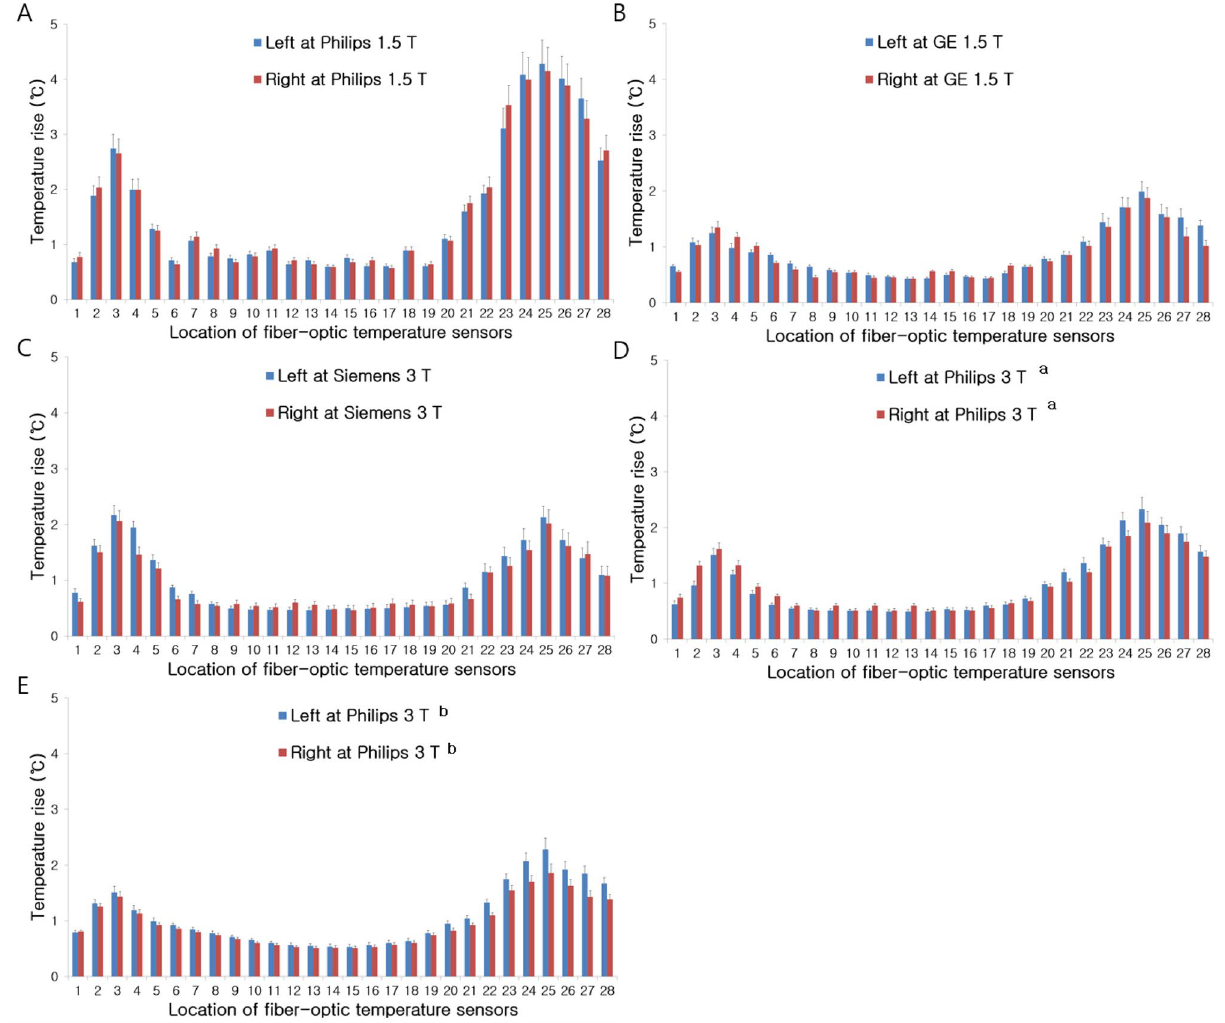
Figure 3. Temperature rise measured via fiber-optic Bragg grating temperature sensors on both sides of the artificial hip joints at 1.5 T Philips with T1w TSE sequence ( A ), 1.5 T GE with IR TSE sequence ( B ), 3 T Siemens with T1 TIRM sequence ( C ), and 3 T Philips with T1w TSE sequence ( D and E ) and imaging parameters as described in Supplementary Table 1. Temperature rise by other two sequences for each scanner is not shown here. The column height is the temperature rise and the error bar is the standard deviation. The peak temperature elevation appears near the head or tail of the artificial hip joint. (a, b = two same model Philips 3 T MRI